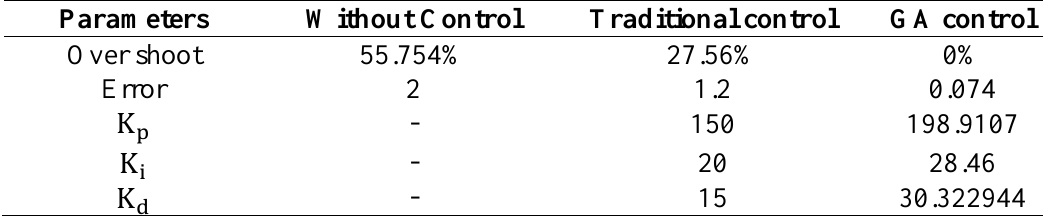
Table 3. Comparison of Test plant 3 response between traditional-PID and GA-PID